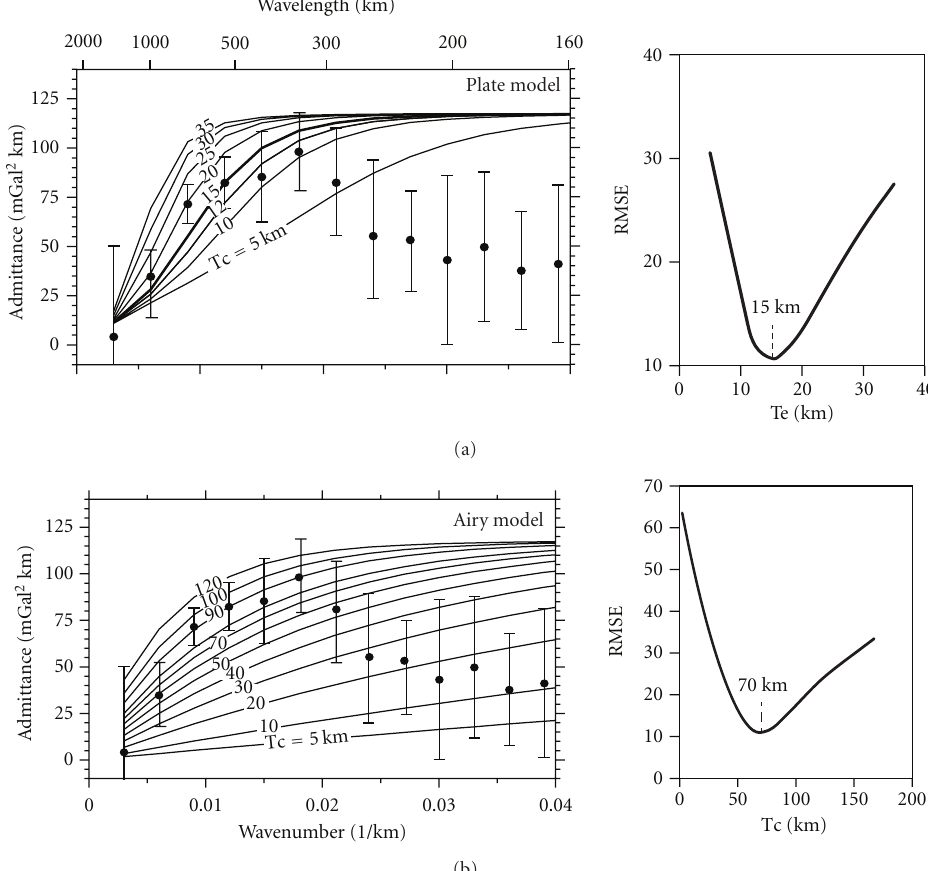
Figure 11: Observed admittance values computed from the FAA and topography profiles in Figure 9 for low wavenumbers, where k = 0 . 0–0 . 04. Observed (solid circles) and theoretical (solid curves) admittance for the (a) Flexure model, where Te is the e ff ective elastic thickness, and (b) Airy isostatic model, where Tc is the mean thickness of the crust as a varying parameter of the model. Admittance errors were computed from the coherence [46]. The best fitting curve for M´erida Andes was the simple flexure model of the lithosphere with Te = 17 ±